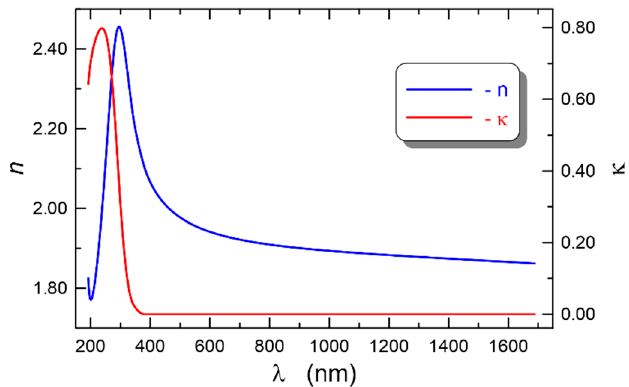
Figure 11. Dispersion characteristics of the refractive index and extinction coefficient for a composite